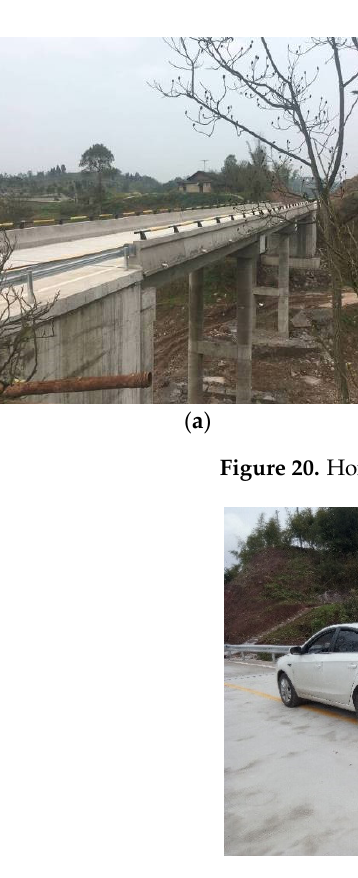
Figure 21. Field tests on site.